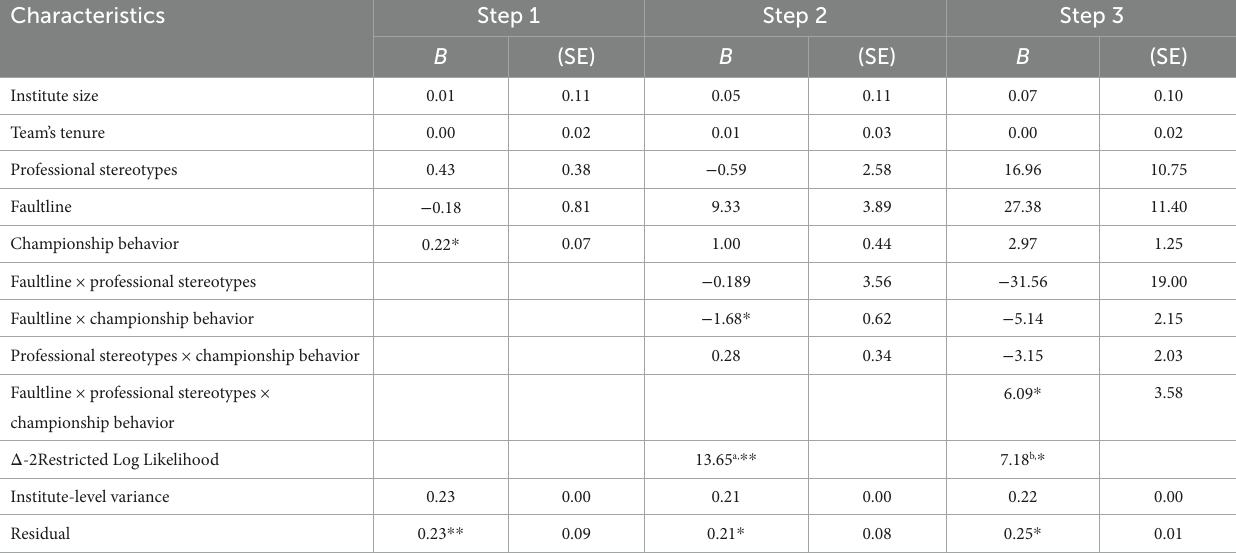
TABLE 2 Results of the linear mixed-model analysis for predicting team’s quality of care from independent variables.